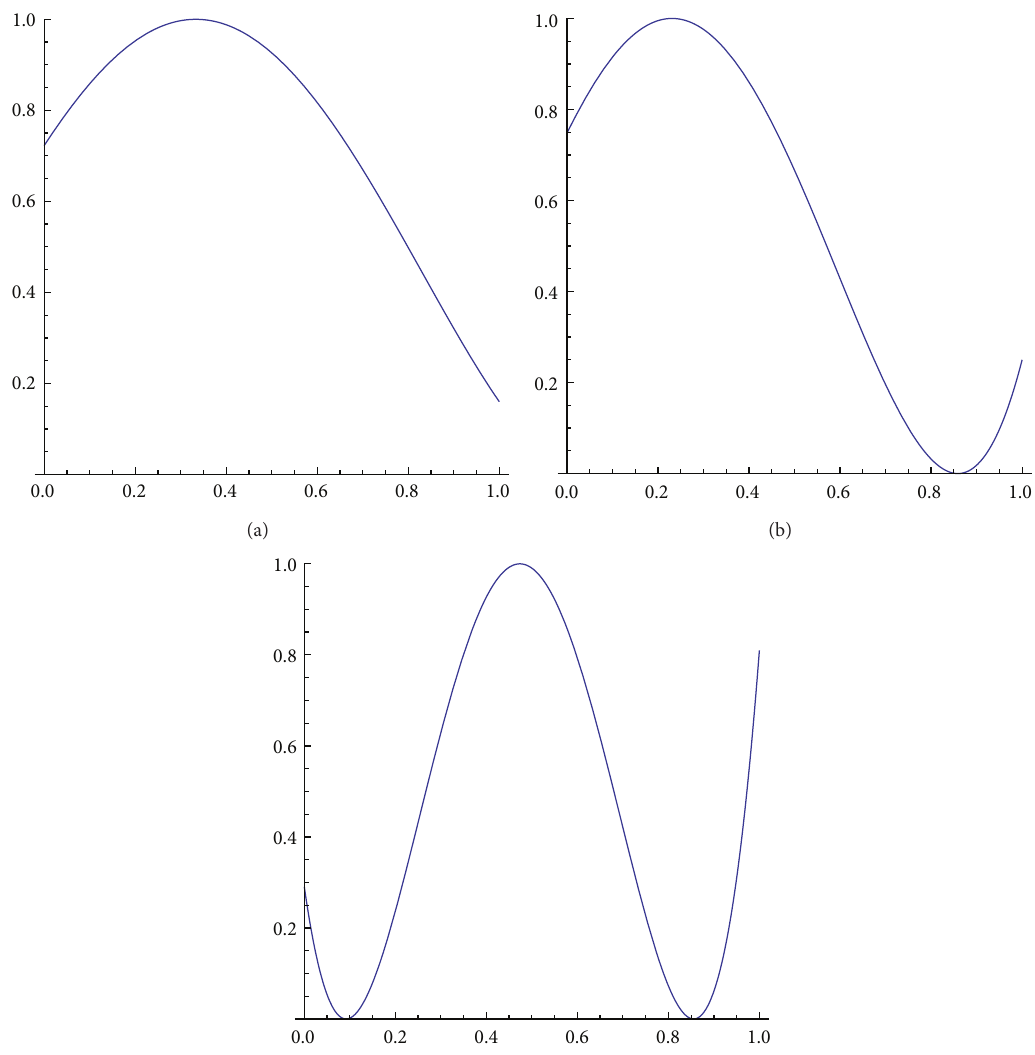
Figure 3: Graphics of the map 𝐺 𝛼,𝛽 for (a) 𝛼 = 1.5 and = 0.6 , (b) 𝛼 = 1.3 and 𝛽 = 1.5 , and (c) 𝛼 = 1.9 and 𝛽 = 1.9 .